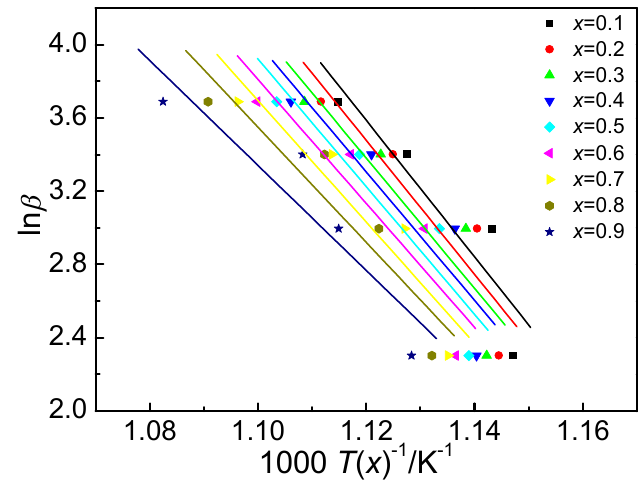
Figure 6. Plots of ln β verse 1000/ T ( x ) of the Fe 68 Nb 6 B 23 Mo 3 glassy alloys.